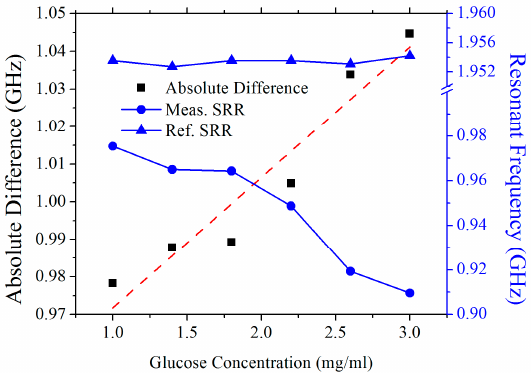
Figure 4. Change in resonant frequency of the reference and measuring resonator with respect to glucose concentration (right axis) and the absolute value of their difference (left axis). A linear fit to difference behavior (R 2 = 0.905) determines the sensitivity as 34.72 MHz/